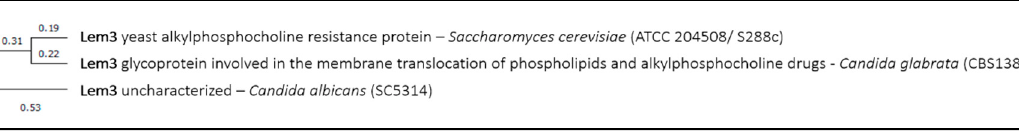
Figure 7. Lem3 phylogenetic analysis. The tree with the highest log likelihood is shown. This analysis involved three amino acid sequences. There were a total of 442 positions in the final dataset. Evolutionary analyses were conducted in MEGA X.